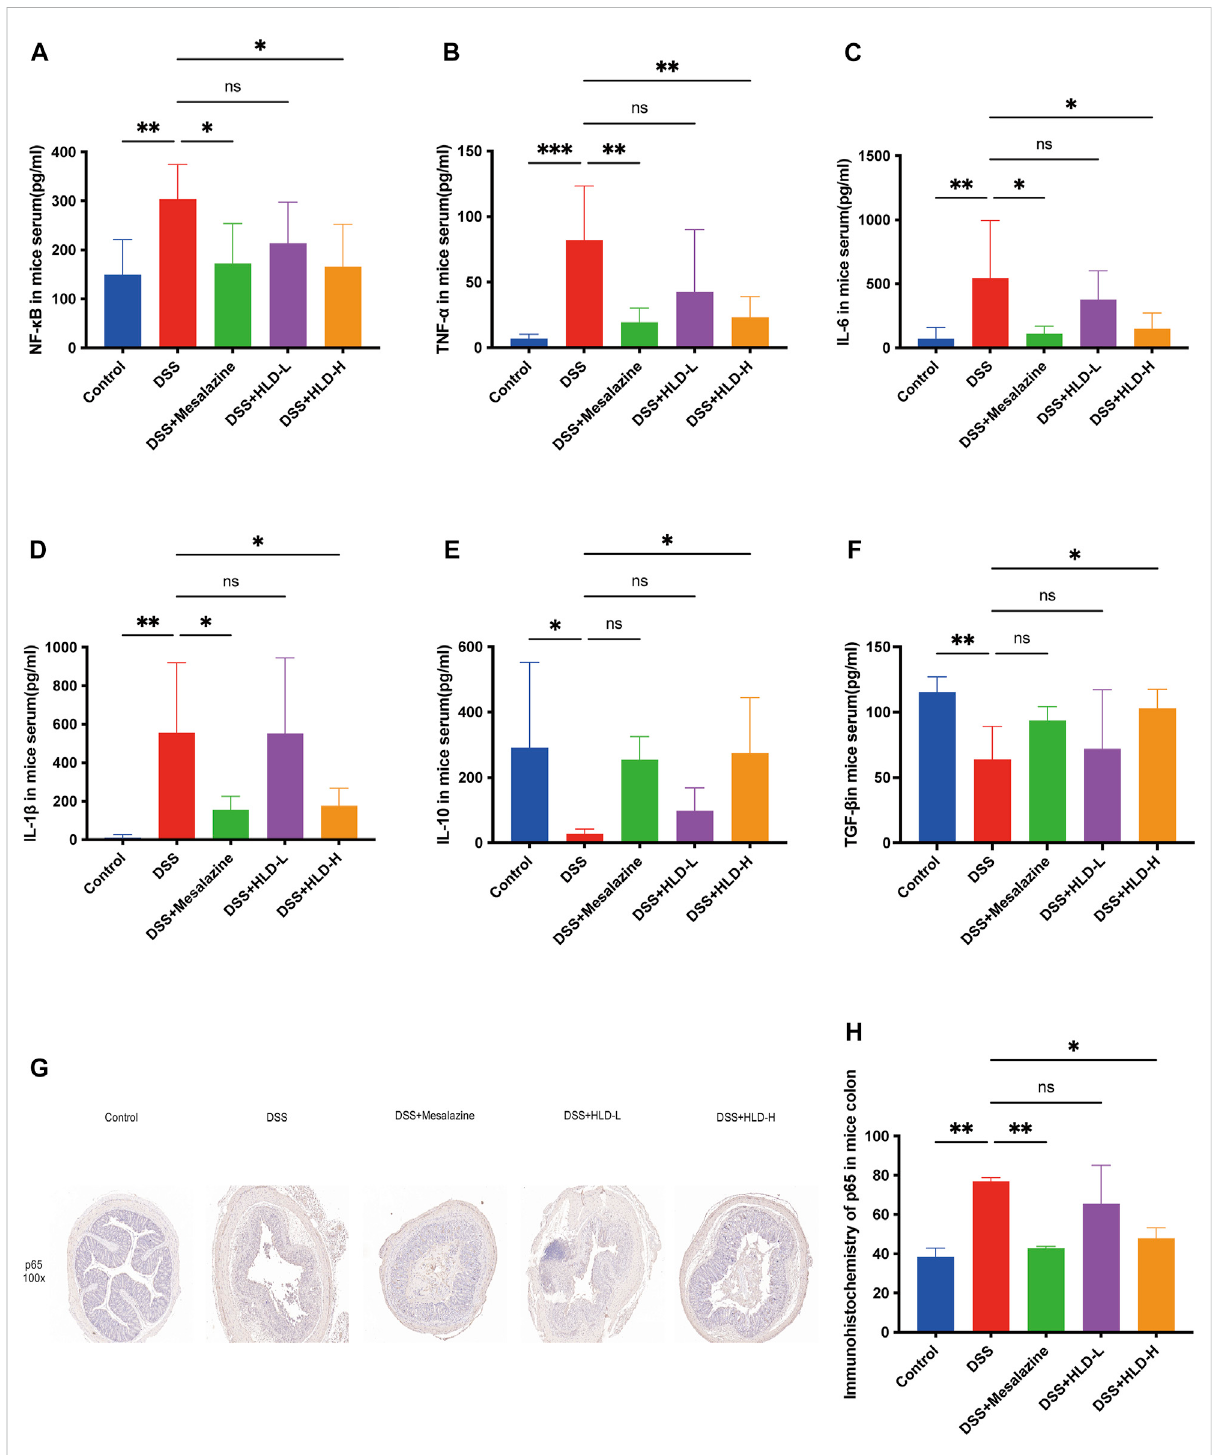
FIGURE 4 HLD exerted anti-in fl ammatory effects by inhibiting NF- κ B in vivo . (A – F) The levels of pro-in fl ammatory cytokines such as NF- κ B, TNF- α , IL-6, IL-1 β and anti-in fl ammatory factors such as TGF- β and IL-10 were detected by ELISA in response to the anti-in fl ammatory activities of HLD. ( n = 6). ( G , H ) Immunohistochemical sections and data comparison of NF- κ B p65 in mice colonic tissues. All data were expressed as the mean ± SD. ( n = 3). * p < 0.05, ** p < 0.01, *** p <